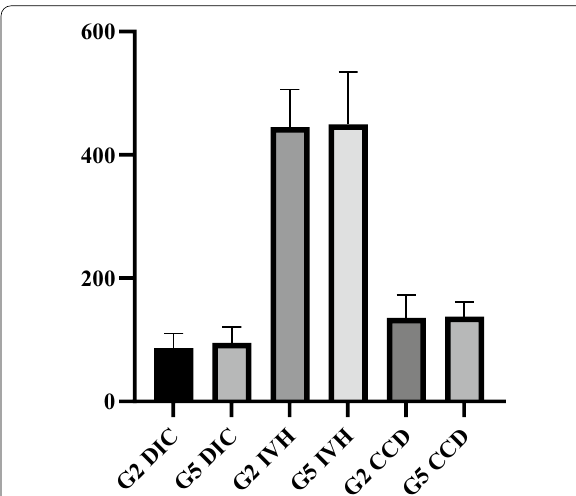
Fig. 2 Levels of antibody (measured by absorbance) anti‑M13 Fig. 1 Ileum villi height and ileum and cecum crypt depth (um) in birds of the different treatment groups. G1: Group inoculated in 42‑day‑old birds inoculated with M13‑infected ECR. G2: Group with phage M13; G2: Group inoculated with E. coli ER2738 infected inoculated with E. coli ER2738 infected by phage M13; G5: Group with phage M13; G3: Group infected by E. coli ER2738; G4: Group inoculated with PBS. DIC: depth of the ileum crypts, IVH: ileum villi inoculated with PEG; G5: Group inoculated with PBS. Control: plate height, CCD: cecum crypt depth. T tests were performed between G2 sensitised with phage without serum. No differences were found (P > and G5 to DIC or IVH or CCD (p 0.05). There was no difference in the ≤ 0.05) by Tukey’s DIC, IVH or CCD between G2 and G5